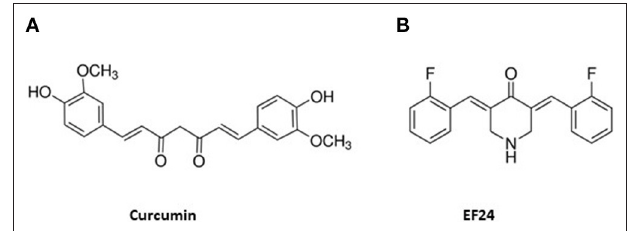
FIGURE 1 | Chemical structures of curcumin (A) and EF24 (B)